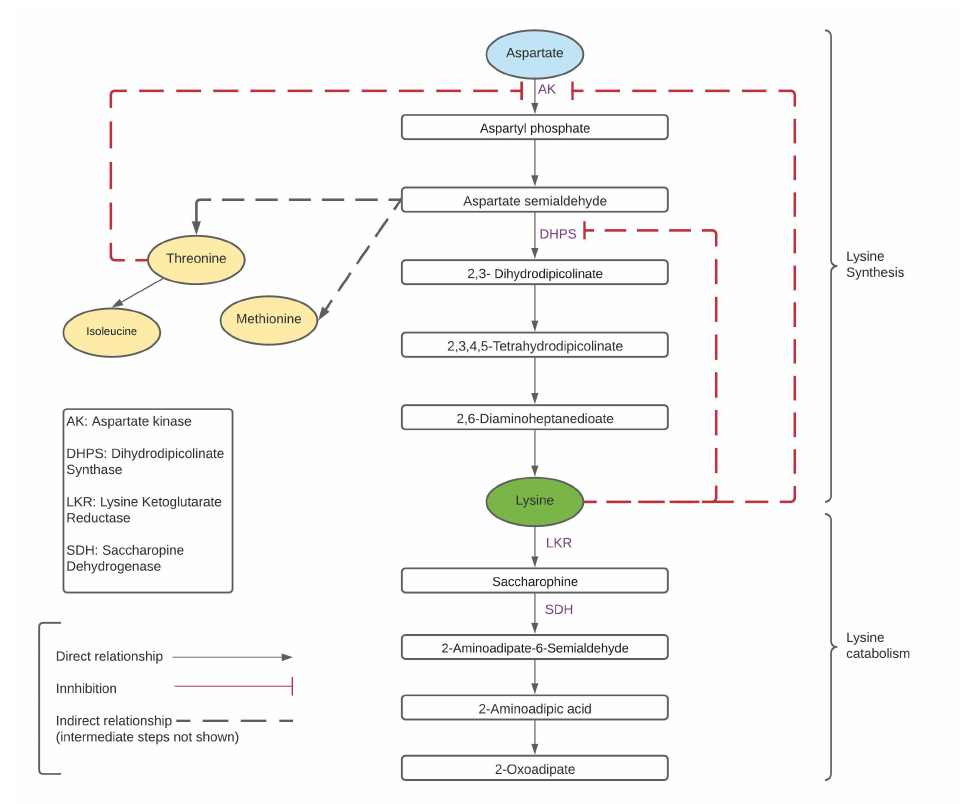
Figure 1. Lysine metabolic pathway for synthesis and